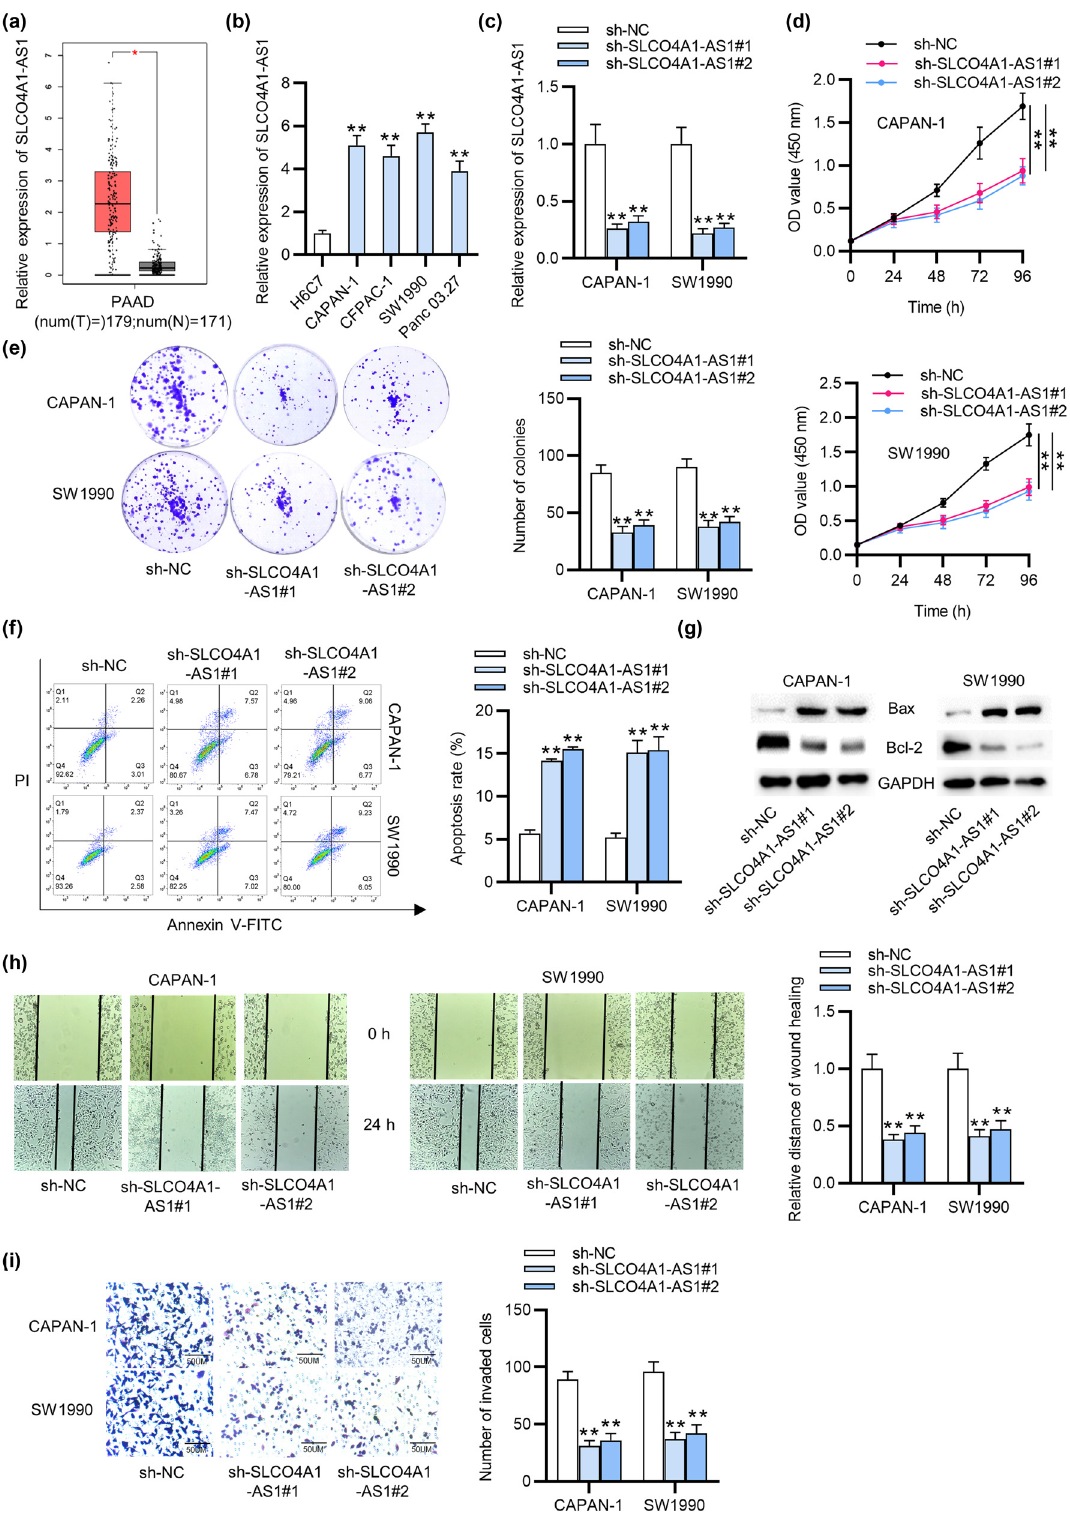
Figure 1: Silencing SLCO4A1 - AS1 inhibits the cellular processes of PC. ( a ) SLCO4A1 - AS1 expression pattern in PAAD was revealed in the boxplot from GEPIA. ( b ) SLCO4A1 - AS1 expression in PC cell lines in contrast with normal H6C7 cells was examined by qRT - PCR. ( c ) qRT - PCR investigated the interfering e ffi ciency of SLCO4A1 - AS1 in PC cells. ( d ) CCK - 8 assay was used to detect PC cell viability a ff ected by SLCO4A1 - AS1 knockdown. ( e ) The e ff ect of SLCO4A1 - AS1 knockdown on CAPAN - 1 and SW1990 cell proliferation was investigated by colony formation assay. ( f and g ) The apoptosis of PC cells transfected with sh - SLCO4A1 - AS1 was analyzed by fl ow cytometry and western blot analysis. ( h ) Wound healing assay measured how downregulated SLCO4A1 - AS1 a ff ected cell migration. ( i ) Transwell assay detected the invasive cap - ability of PC cells after SLCO4A1 - AS1 depletion. All experiments were performed in triplicate. More images for replicates are provided in a supplementary fi le named Replicate images. * p < 0.05 and ** p <